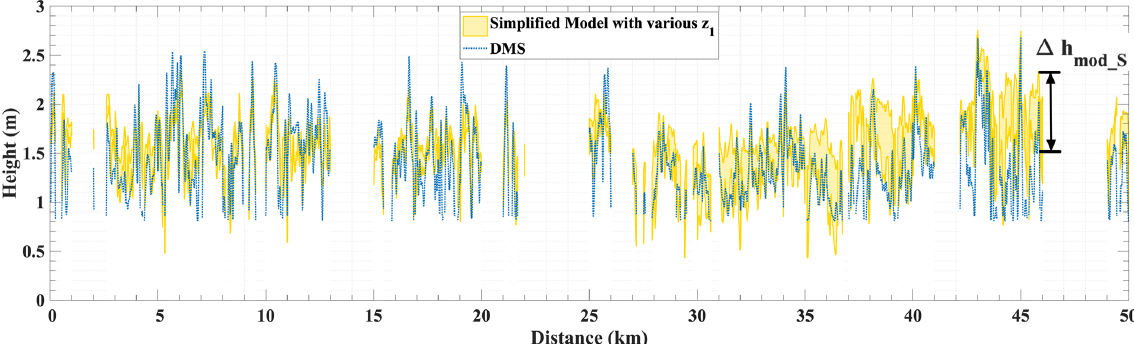
Figure 15. Yellow area: sea ice height profiles from the simplified model in Pauli-1 polarization with z 1 from − 0 . 05 to − 0 . 75m. Blue dash line: sea ice height profiles from DMS measurements. Each profile represents the height along a 1 × 5000-pixel section at the center of the coregistered segment. The mis-coregistered and h DMS -below-0.8m samples are excluded from the